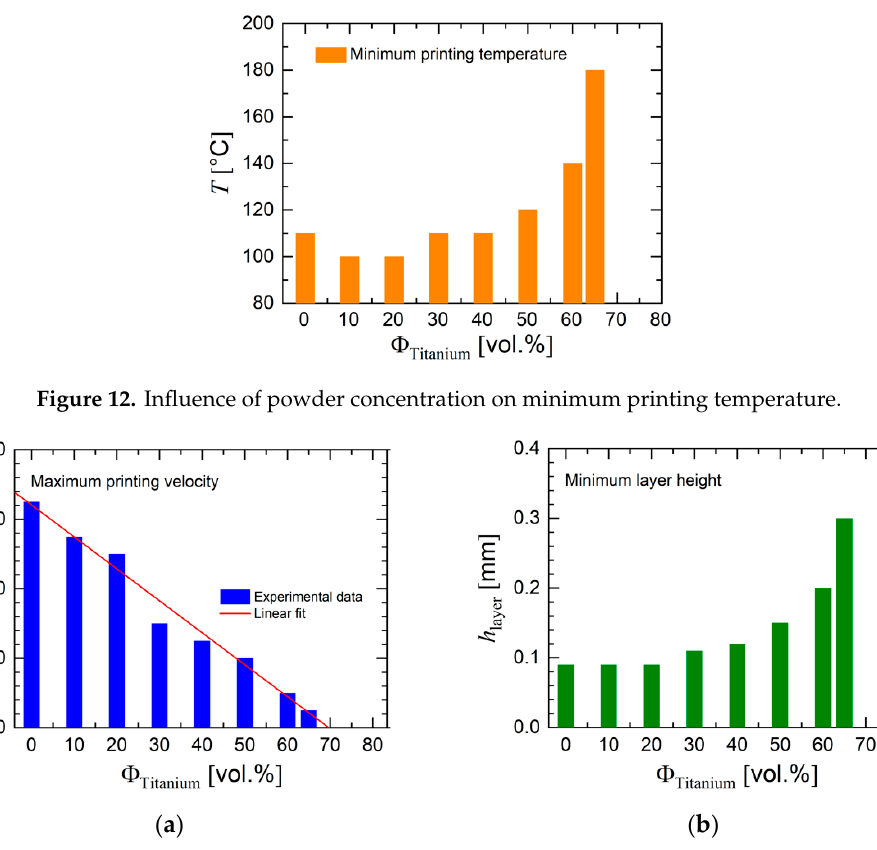
Figure 11. Magnitude of complex viscosity η * for the feedstocks with ( a ) 50 and ( b ) 60 vol.% Ti particles as a function of angular frequency ω at five temperatures. The shear amplitude γ 0 was 1%.